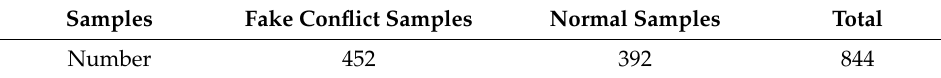
Table 2. VGG classification confusion matrix.